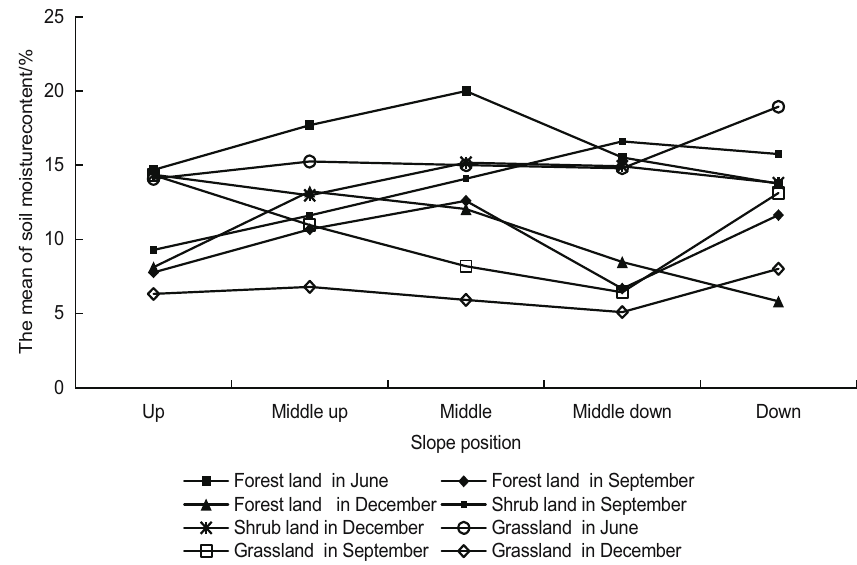
Figure 1: Characteristics of soil moisture of di ff erent soils with